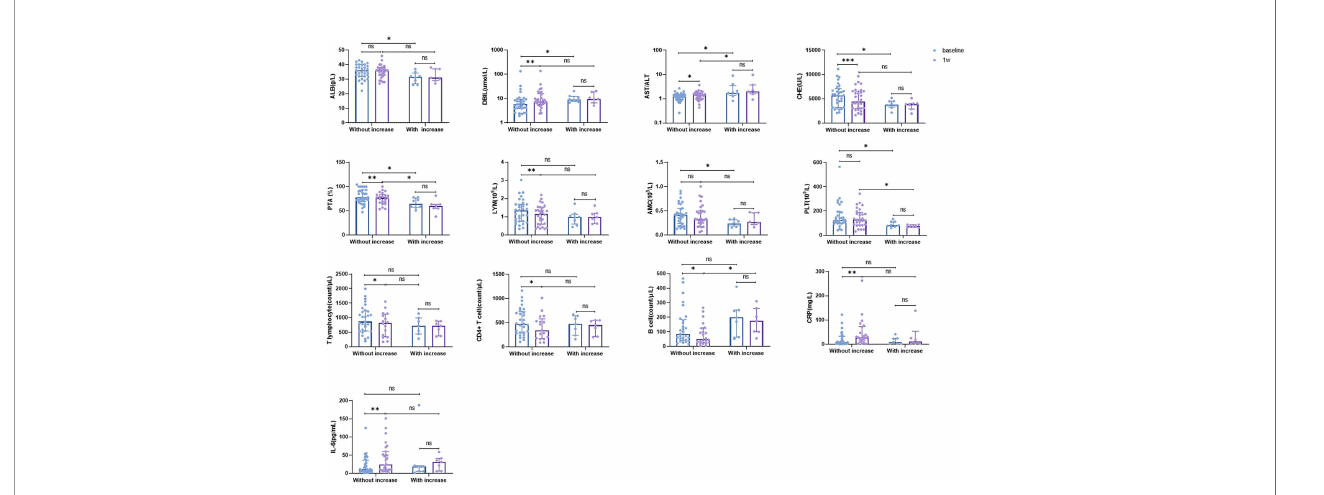
FIGURE 4 | Baseline characteristics and trends of some clinical parameters in patients with or without increasing HBsAg level. ALB, albumin; AMC, absolute monocyte count; CHE, cholinesterase; CRP, C-reactive protein; DBIL, direct bilirubin; IL-6, interleukin-6; LYM, absolute lymphocytes; PLT, platelets; PTA, prothrombin activity. ns: >0.05; ***: ≤ 0.005; **: ≤ 0.01; *: ≤